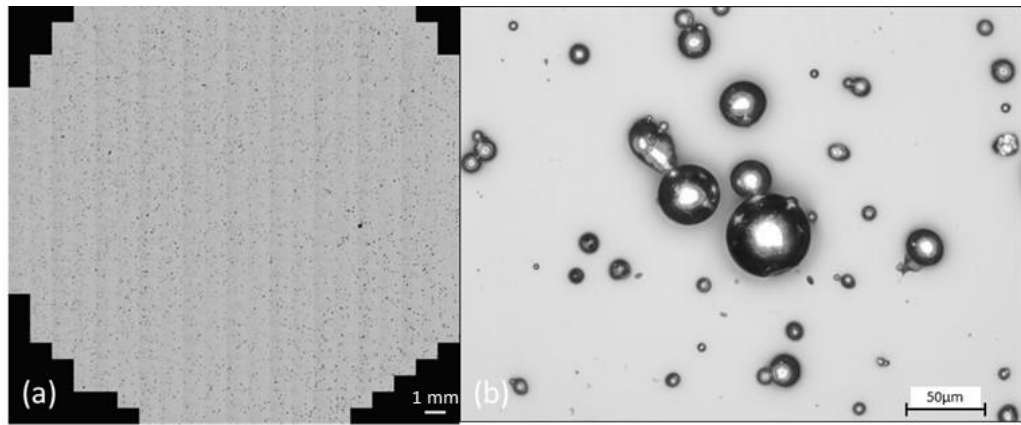
Figure 6. Powder shape analysis micrographs showing ( a ) a 10.8 mm radius scan area and ( b ) magnified view of the particles.